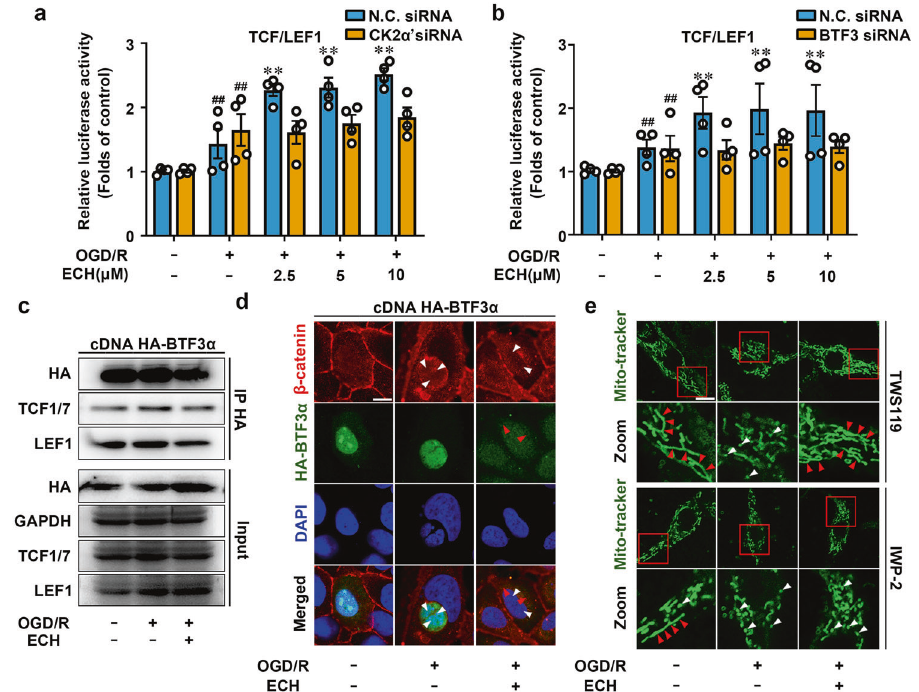
Fig. 5 BTF3 promotes Mfn2 expression in Wnt/ β -catenin signal-dependent manner. a , b ECH enhanced TCF/LEF1 reporter gene activity, which was inhibited by CK2 α ′ or BTF3 knock-down. c ECH inhibited the interaction of BTF3 α with TCF1/7 and LEF1. HEK293T cells were transfected with HA-tagged BTF3 α and treated by ECH (10 μ M) for 6 h. Co-IP was performed with anti-HA antibody, followed by immunoblotting analysis. d Cytoplasmic translocation of HA-BTF3 α (green) from nucleus and nuclear translocation of β -catenin (red) from cytoplasm were promoted by ECH (scale bar: 20 μ m). e IWP-2 blocked ECH-induced mitochondrial fusion; however, TWS119 did not show similar effect. Arrows (red) indicate branched healthy mitochondria. Arrows (white) indicate spherical dysfunctional mitochondria (scale bar: 20 μ m). Data are expressed as the mean ± SD. ## P < 0.01 vs. control group. * P < 0.05, ** P < 0.01 vs. OGD/R